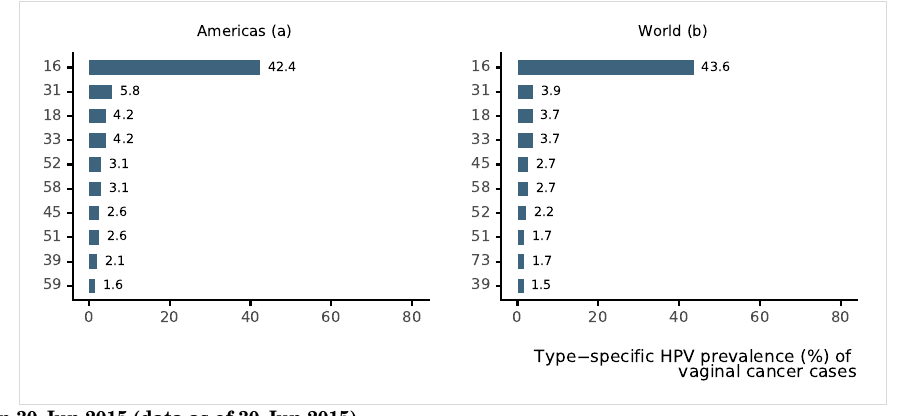
Figure 66: Comparison of the ten most frequent HPV types in cases of vaginal cancer in Americas and the World